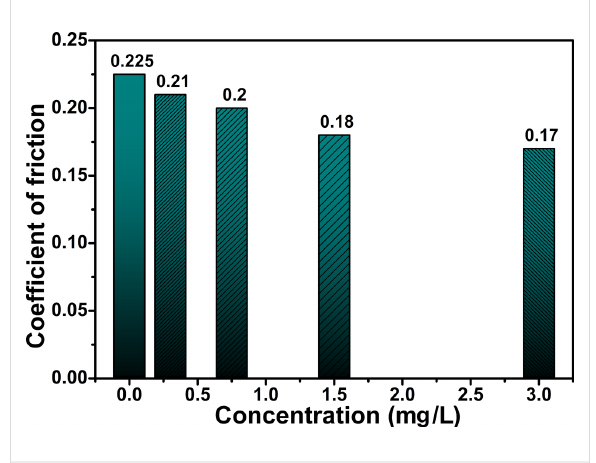
Figure 4: Coefficient of friction at low N-rGO concentrations.